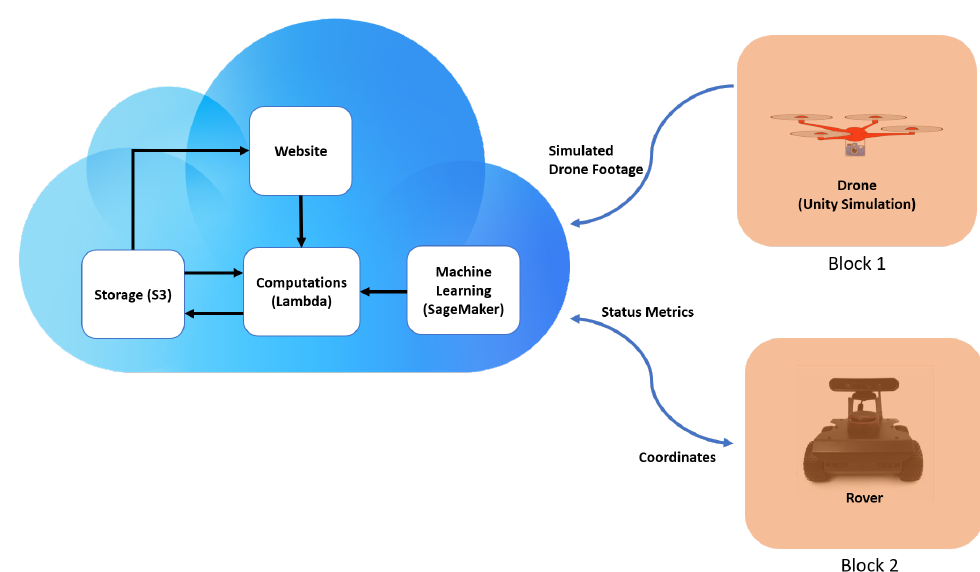
Figure 2. System diagram highlighting parts involved with Cloud (AWS). Block1 and Block2 are the vehicles connected to the network and serve as individual blocks of the blockchain.